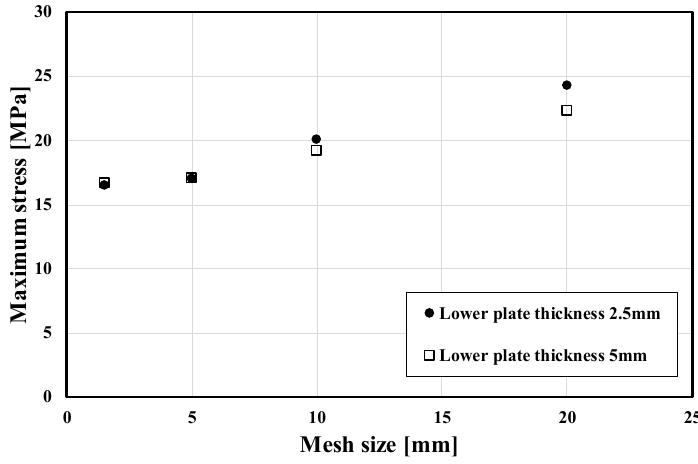
Figure 4. Meshing convergence study.